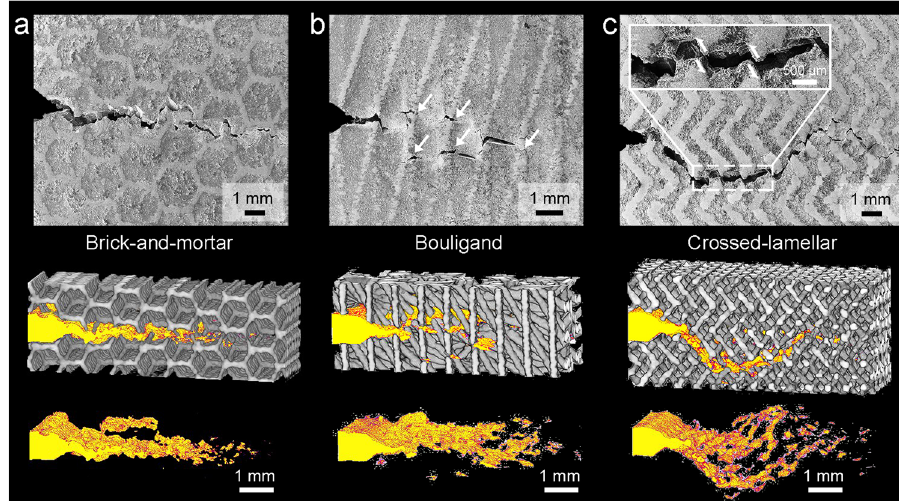
Fig. 6 Cracking morphologies and toughening mechanisms in the bioinspired Mg-Ti composites. SEM images and CT volume renderings of the quasi- static fracture toughness samples for the composites with bioinspired ( a ) brick-and-mortar, ( b ) Bouligand, and ( c ) crossed-lamellar architectures. The CT images were processed by fi ltering out the signals of constituents and highlighting the cracking regions. The white arrows in ( b ) indicate the microcracks ahead of the crack tip. The inset in ( c ) magni fi es the zig-zag cracking path and the resulted frictional sliding between crack faces as indicated by the